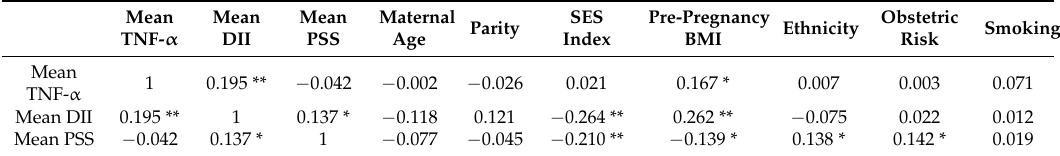
Table 2. Bivariate associations between TNF- α , DII, PSS, and maternal characteristics.